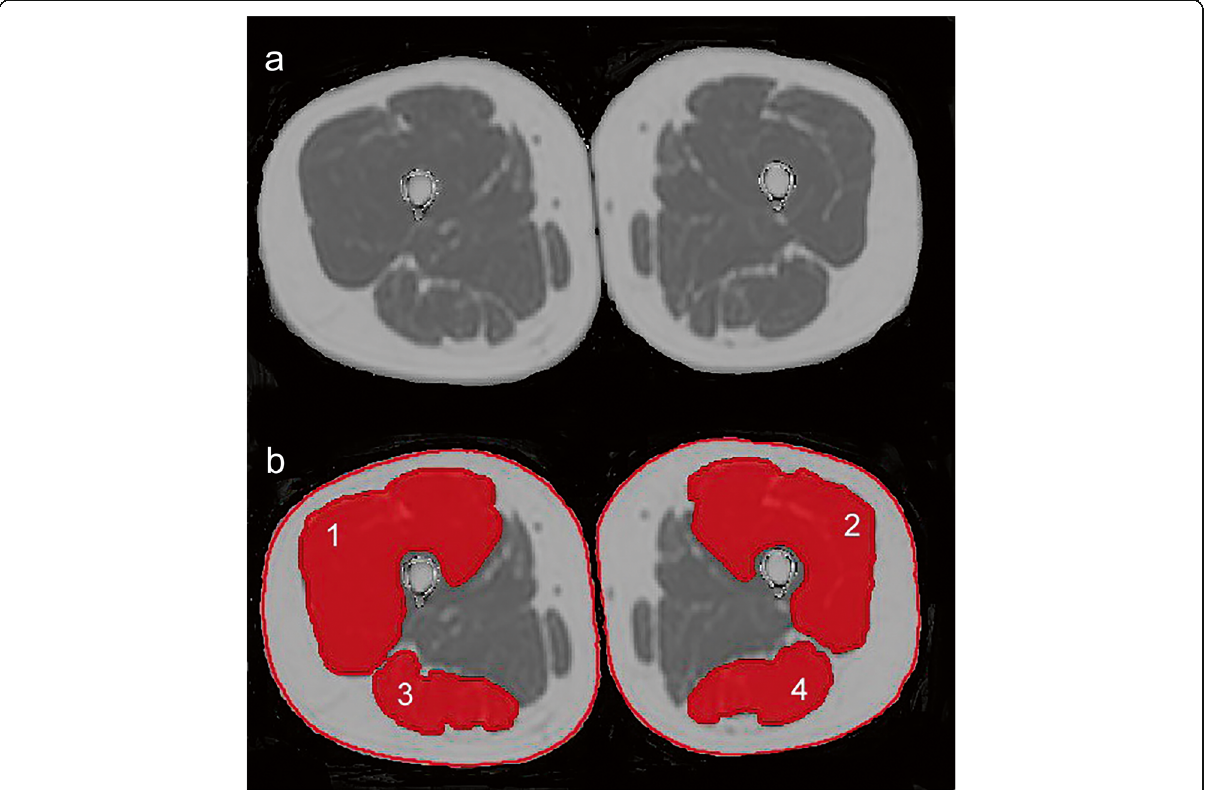
Fig. 1 Chemical shift encoding-based water-fat magnetic resonance imaging (MRI) and placement of regions of interest (ROIs). a Representative proton density fat fraction (PDFF) map. b PDFF map with superimposition of manually segmented muscle compartments defined as ROIs: (1) right quadriceps muscle, (2) left quadriceps muscle, (3) right ischiocrural muscles, and (4) left ischiocrural muscles. The red lines around the thigh represent the segmentation of the entire thigh